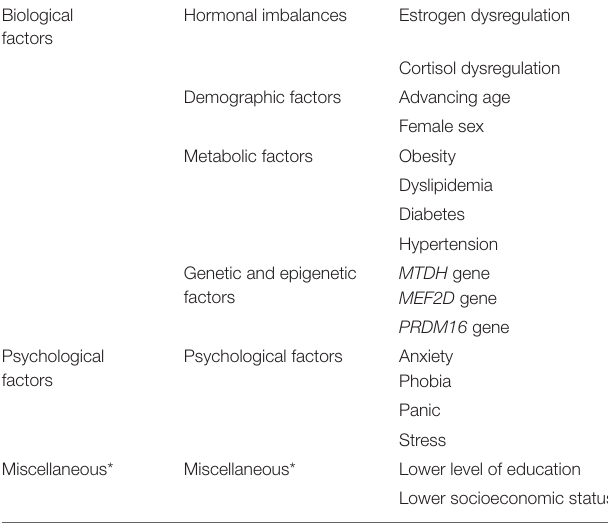
TABLE 1 | Risk factors for